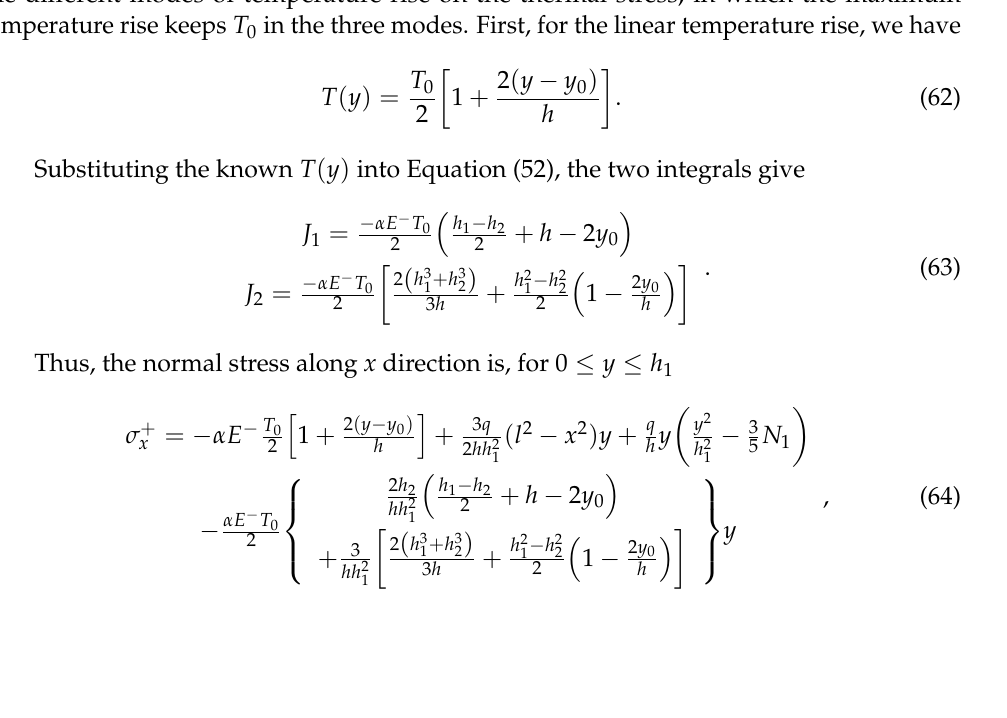
Figure 9. The total stress when α E − T 0 / q =